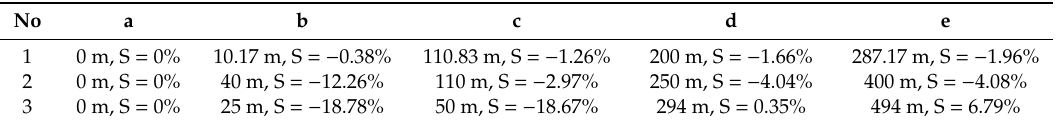
Table 2. Description of parameters in Figure 5 (production time (m, min), subsidence ratio (S,